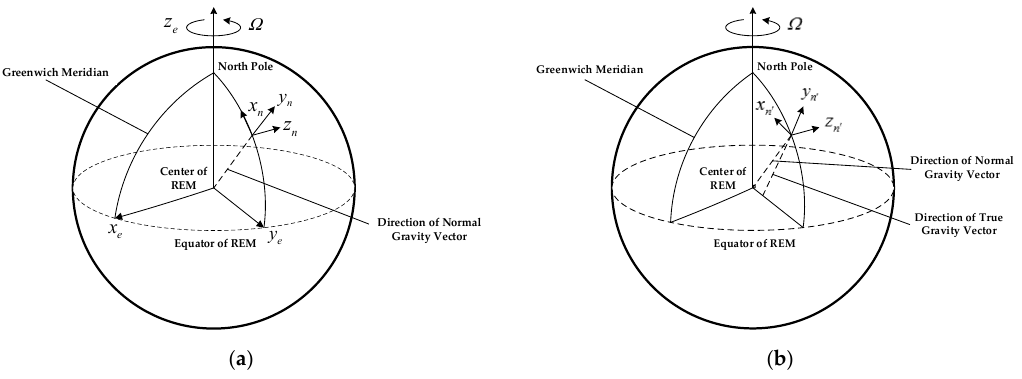
Figure 3. The definition of navigation coordinate frame, ( a ) is the diagram of n and ( b ) is the diagram of n’ .